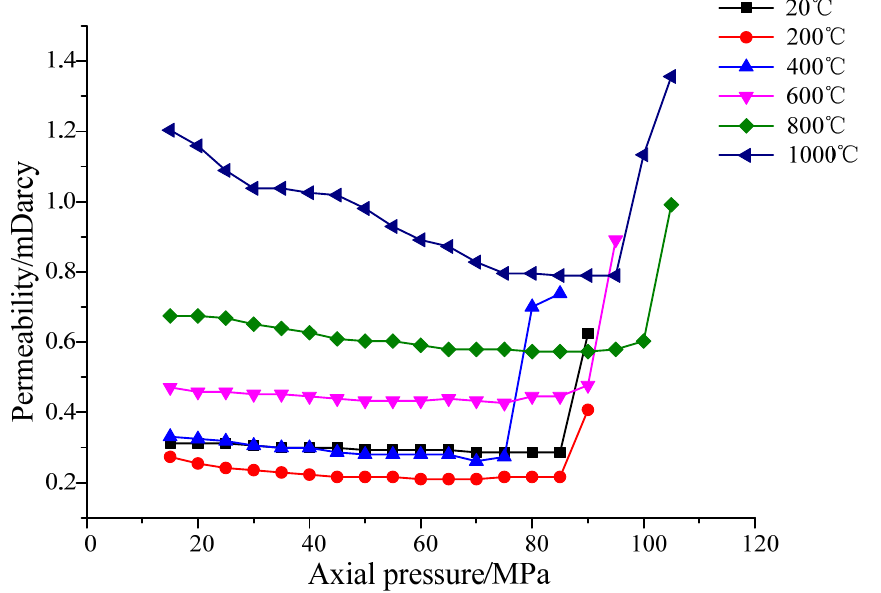
Figure 7. Curves of sandstone permeability variation with axial pressure at different temperatures.